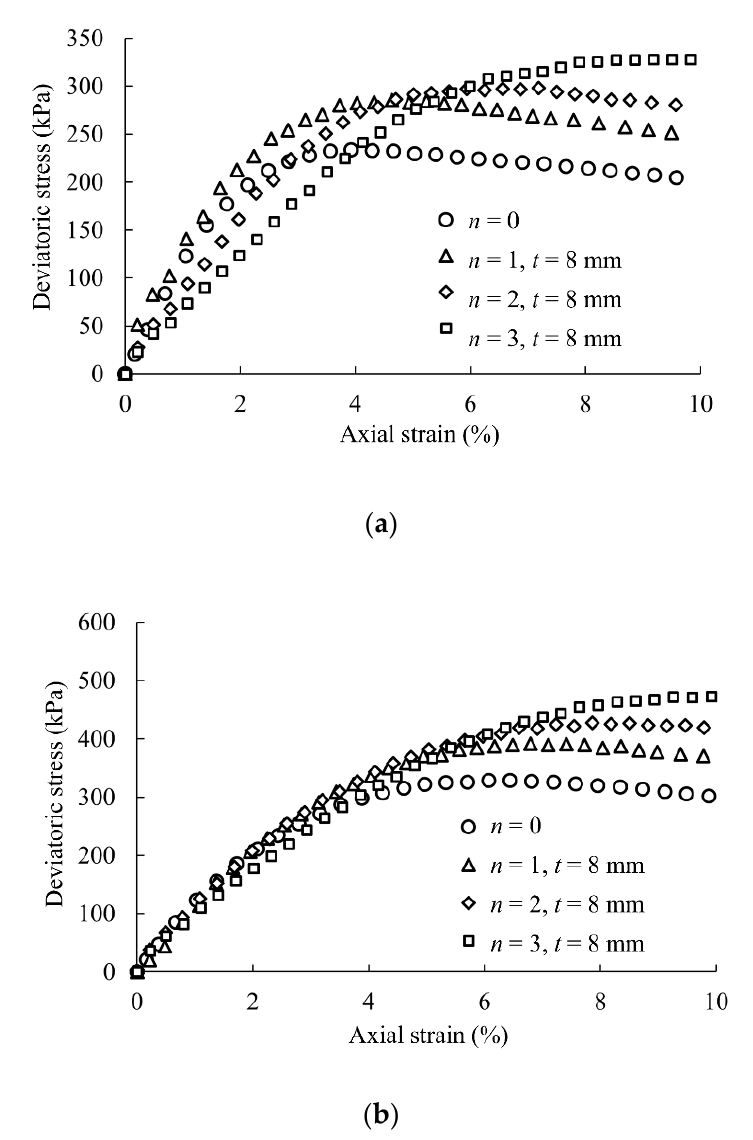
Figure 9 delineates the deviatoric stress–axial strain curves of the LGSCR samples at confining pressures of 150, 250, and 400 kPa and with different numbers of sand layers. As can be seen in this figure, the strength of the LGSCR samples under a specific confining pressure rises significantly with an increase in the number of sand layers. At the 150 kPa confining pressure, the elastic region behavior and the apparent initial tangent modulus of the four LGSCR samples have obvious differences. This phenomenon occur because the geogrid-reinforced sand layers have a negative dilatancy behavior, which is followed by a dilatancy behavior at a low confining pressure. Compared with the SCL samples, the LGSCR samples have a higher σ p at the same n value. Raising the number of sand layers gradually declines the strain-softening degree of the LGSCR samples but further enlarges the ε n corresponding to the σ p compared with the SCL samples. The above results demonstrate that laying the geogrid in the sand layer can effectively improve the σ p of the samples and further enhance their ductility. The larger the number of sand layers, the more remarkable the effect.